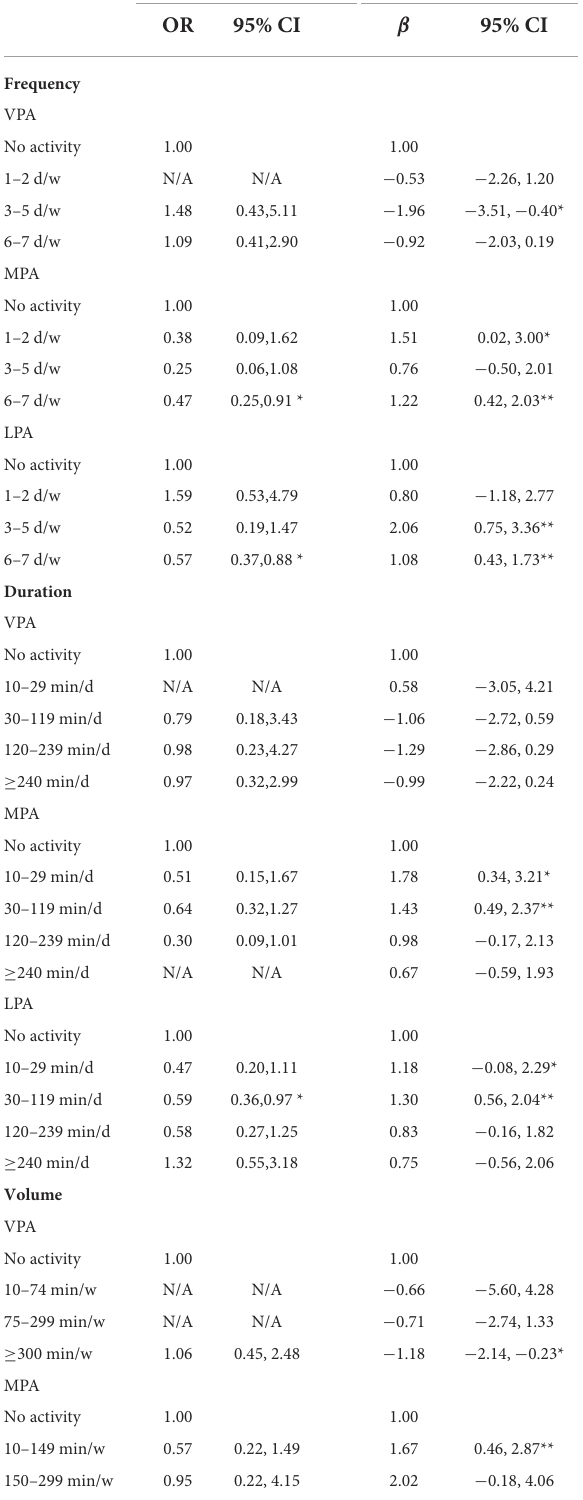
TABLE 2 Associations between physical activity and daily physical activity ability and cognitive function of patients with heart disease.